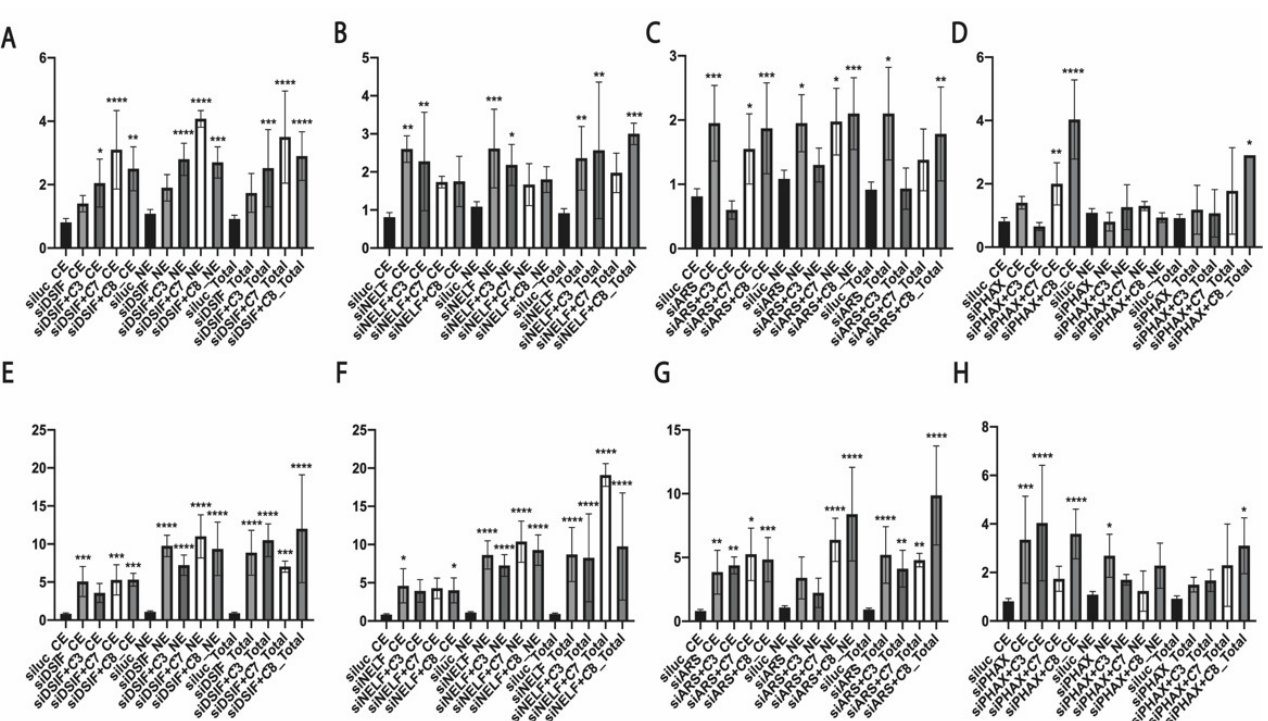
Figure 4. Processing efficiency of hTR and U2 snRNA. To compare the processing efficiency, the relative amount of premature transcripts (3′) was normalized to the relative amount of total transcripts (M+3′). ( A – D ) Histograms demonstrating the efficiency of processing hTR in the cytoplasmic (CE) and nuclear (NE) fractions and whole cell extract (Total) after the knockdown of the specified RNA biogenesis factor. ( E – H ) Histograms demonstrating the efficiency of processing U2 snRNA in the cytoplasmic (CE) and nuclear (NE) fractions and in the whole cell extract (Total) after the knockdown of the specified RNA biogenesis factor. siluc — control knockdown performed with siRNA specific to Firefly luciferase mRNA; siC3 — knockdown performed with siRNA specific to ZFC3H1; siC7 — knockdown performed with siRNA specific to ZCCHC7; siC8 — knockdown performed with siRNA specific to ZCCHC8. * p < 0.1, ** p < 0.01, *** p < 0.001, and **** p < 0.0001 by Dunett’s multiple comparison test.